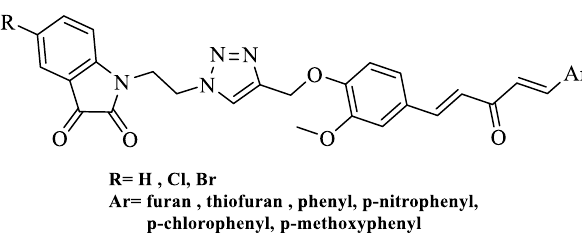
Fig. 3. Isatin derivatives as tubulin inhibitors (Sharma et al., 2015)